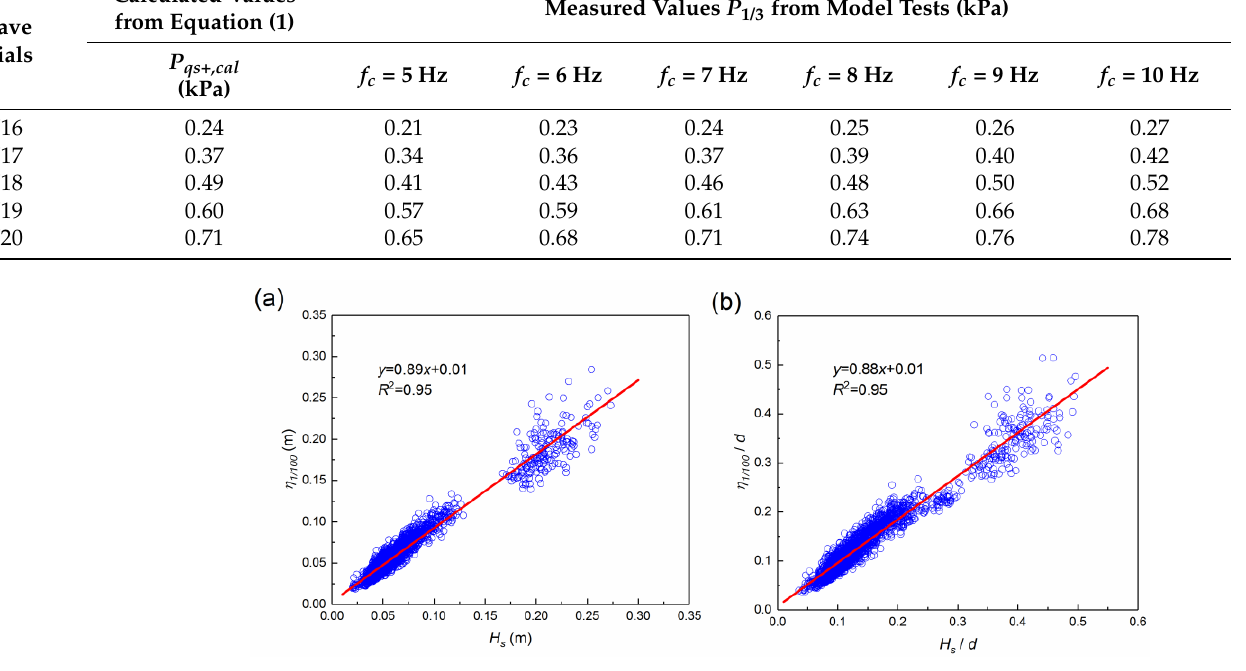
Figure 5. Relationship between the incoming significant wave height H s and characteristic wave crest height η 1/100 in ( a ) dimensional form and ( b ) nondimensional form.